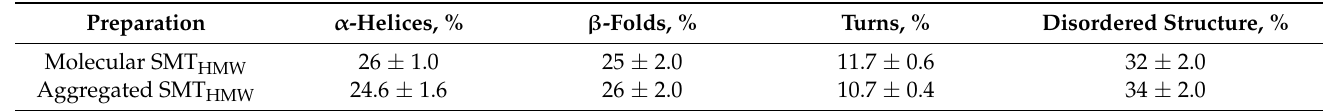
Table 1. Secondary structure content in chicken titin samples calculated by the FTIR method.